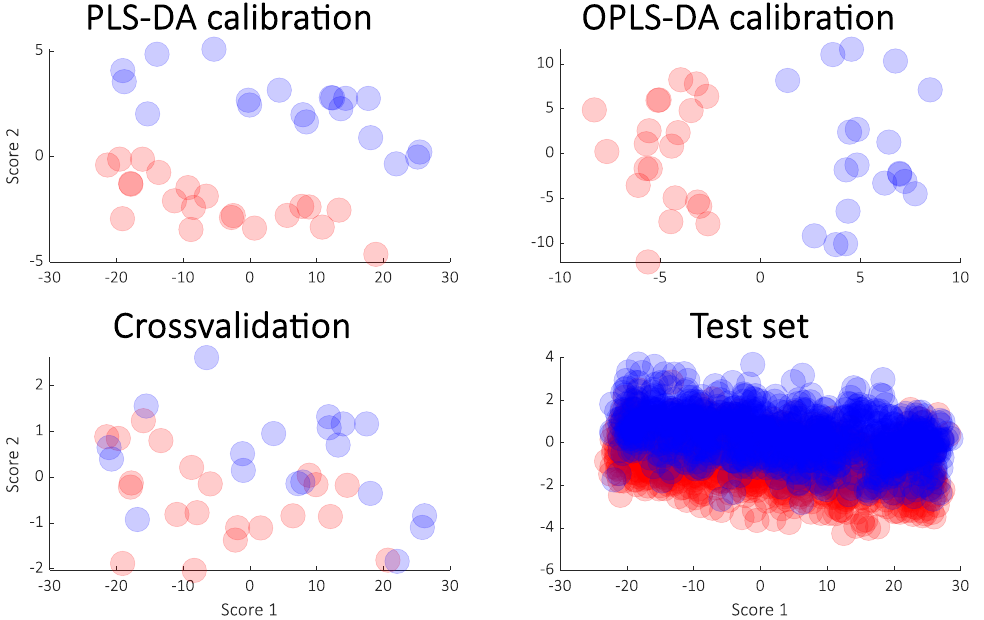
Figure 2. Calibrated score plot from PLS-DA ( upper left ) and the OPLS-DA (orthogonal PLS-DA) ( upper right ) from the simulated data. The cross-validated scores from PLS-DA ( lower left ) and the score plot obtained from the test samples ( lower right ) are also shown.